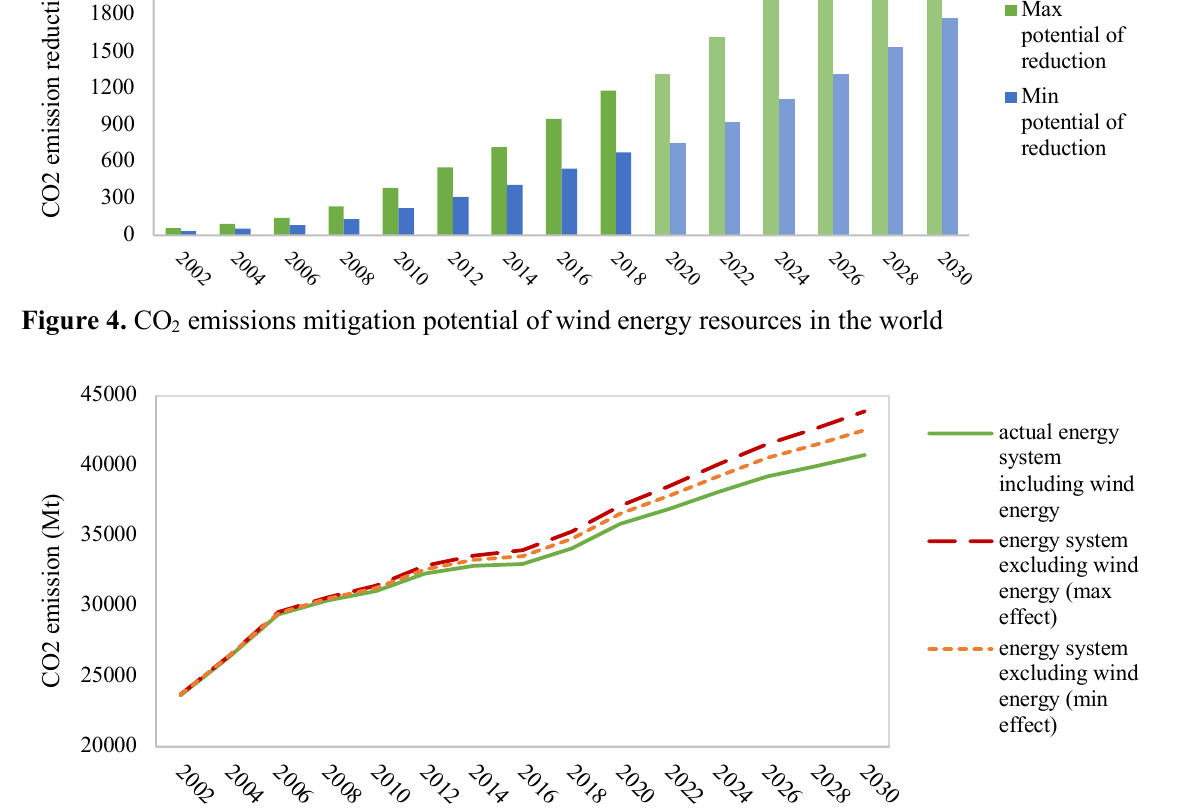
Figure 5. Effect of wind energy development on CO2 emissions mitigation in the